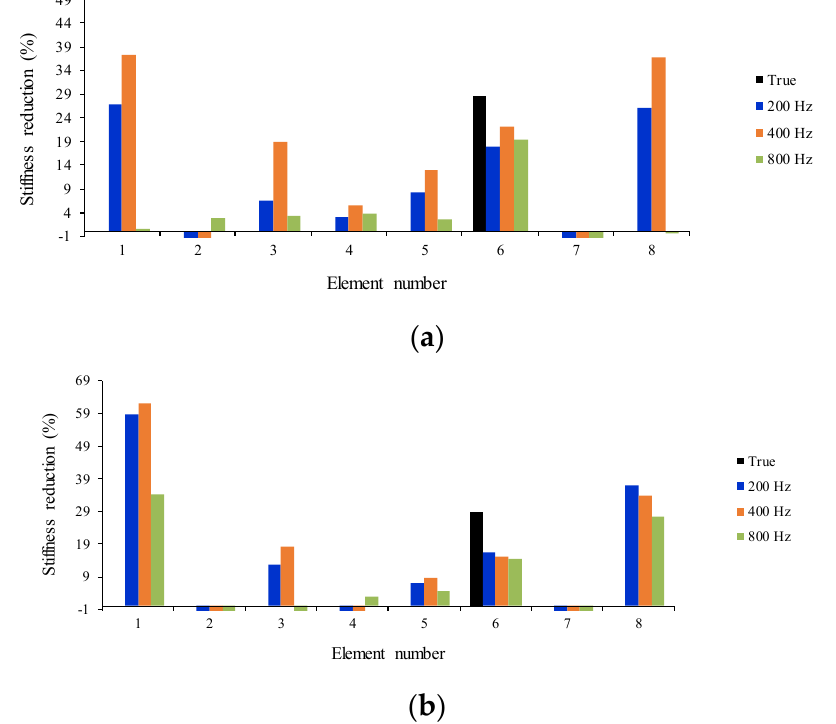
Figure 21. The effect of sampling frequency on damage detection- Damage case 2. ( a ) Speed: 0.47 m/s; ( b ) Speed: 0.94 m/s.